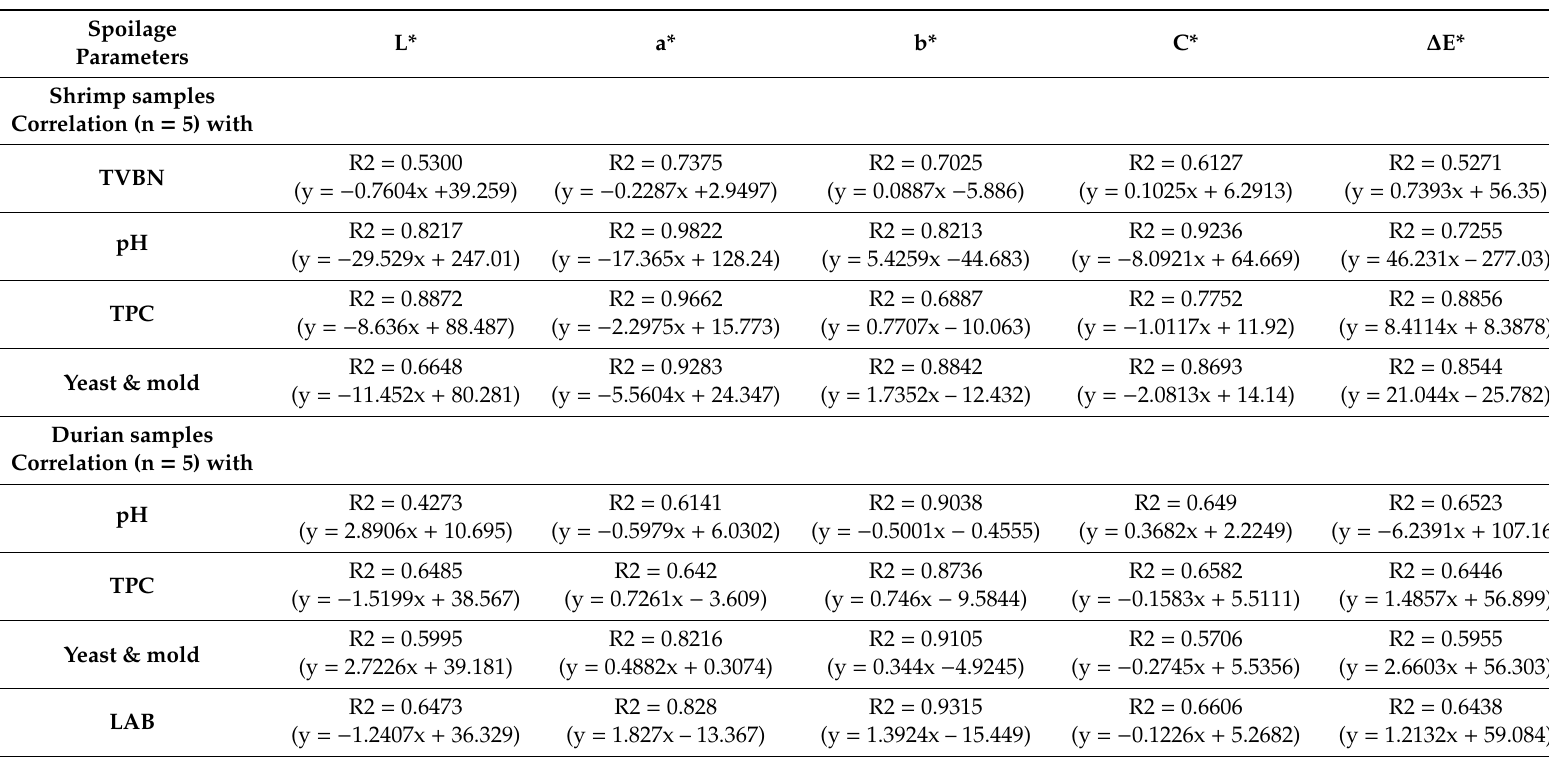
Table 5. Correlation studies between color changes (L*, a*, b*, C* and ∆ E*) of sensing film with spoilage parameters for shrimp and durian samples stored at ambient temperature (28 ± 1 ◦